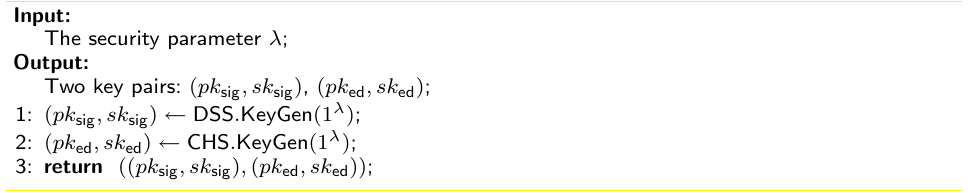
Algorithm 1 KeyGen: The key generation algorithm